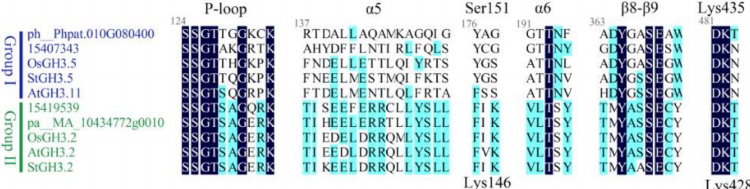
Figure 3. Predictions of protein structure by analyzing 10 GH3 proteins. The selected proteins belonged to groups I and II. AtGH3.11 plays a key role in the JA pathway, and its mutant is named JAR1 [13]. YDK1-D is an AtGH3.2 mutant and responds to auxin [25]. The grey numbers (124, 137, 176, and so on) stand for the location of amino acids. The black annotates symbolize the secondary structure of the protein.